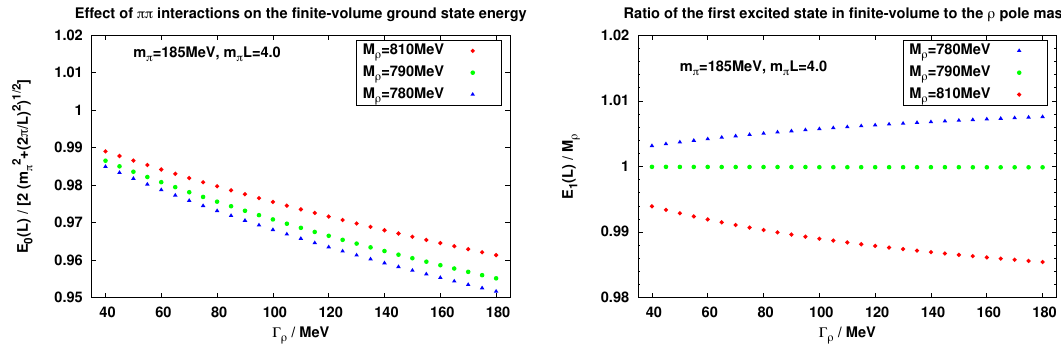
Figure 5 . Corrections to energy levels relative to the naive expectation of a non-interacting, p -wave two-pion state and a (cid:26) -state, for parameters corresponding to ensemble G8 and assuming the GS pion form factor. Left: correction to the expectation E 0 = 2 energy as a function of the width (cid:0) (cid:26) , for three values of the mass m (cid:26) . Right: correction to the expectation E 1 = m (cid:26)